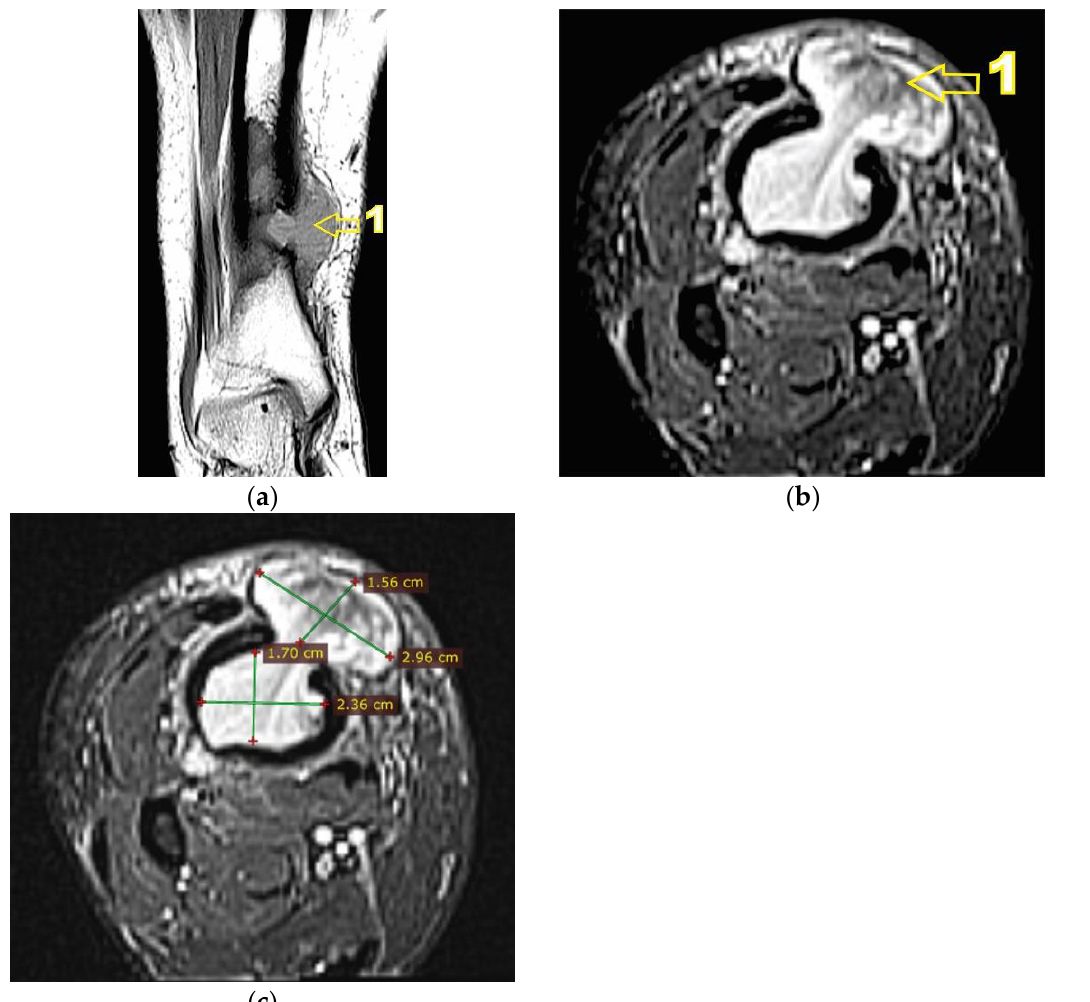
section. 1—extraosseous expansion of the tumor formation.